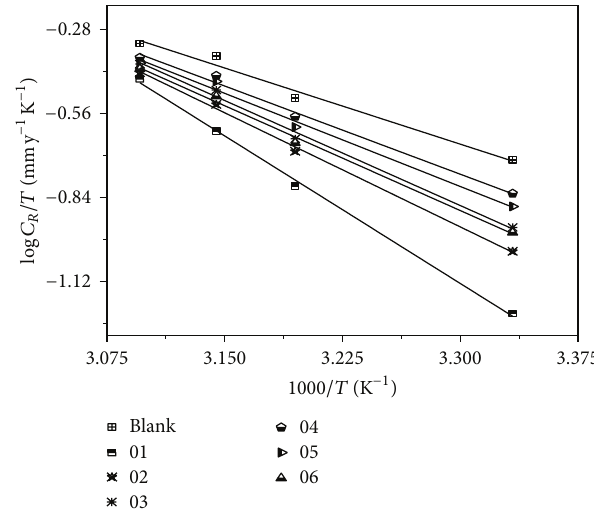
Figure3:Arrheniusplotsoflog 𝐶 𝑅 /𝑇 versus 1/𝑇 formildsteelin1N H 2 SO 4 in the absence and presence of inhibitors(01–06) at optimum concentration (0.4 × 10 −3